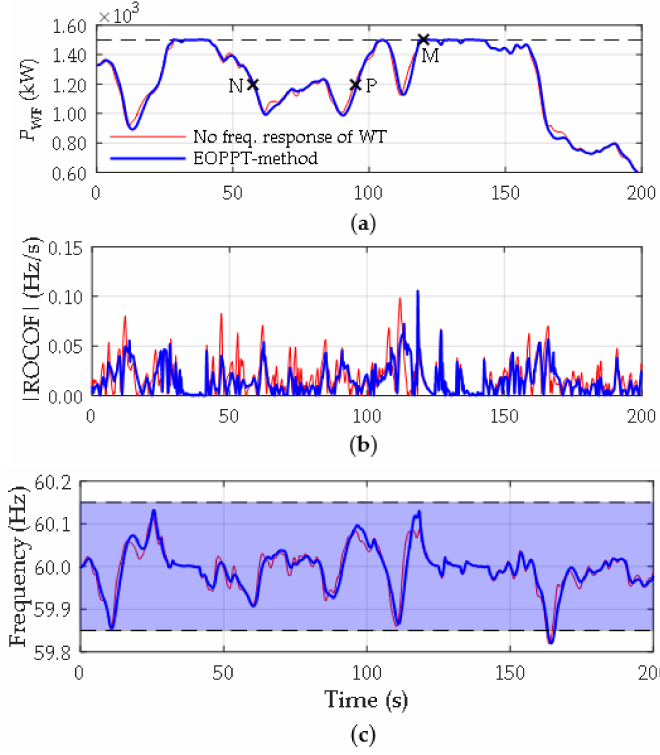
Figure 22. Time domain simulation with the application of the EOPPT-method: ( a ) Dispatched wind power; ( b ) ROCOF and; ( c ) Grid